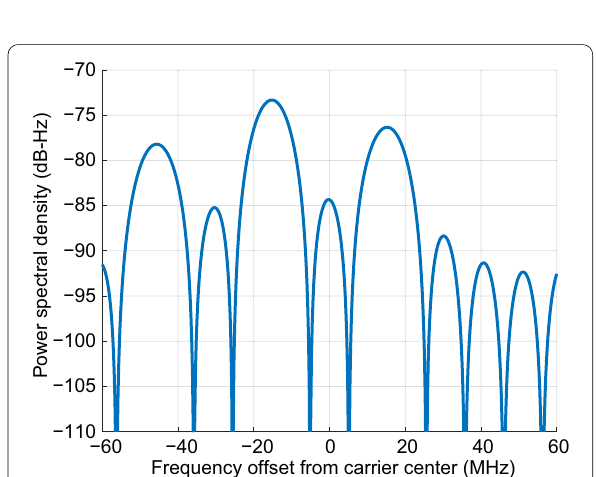
Fig. 9 Power spectral density of improved Type-III ACE-BOC multiplexing modulation